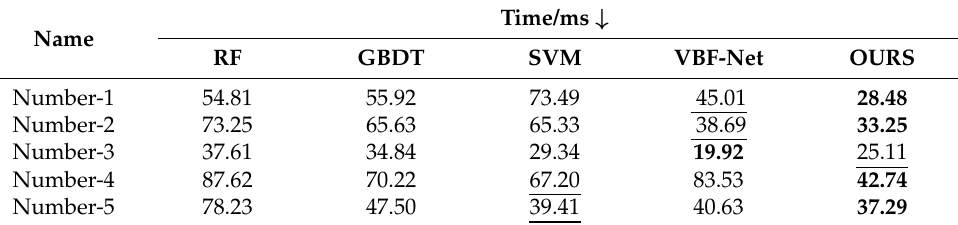
Table 5. Time-consuming statistics of cable extraction for five groups of samples by different methods (bold indicates the optimal result, underline indicates the suboptimal result, the arrow pointing up indicates that the larger the value is, the better, and the arrow pointing down indicates the smaller the value is, the better).